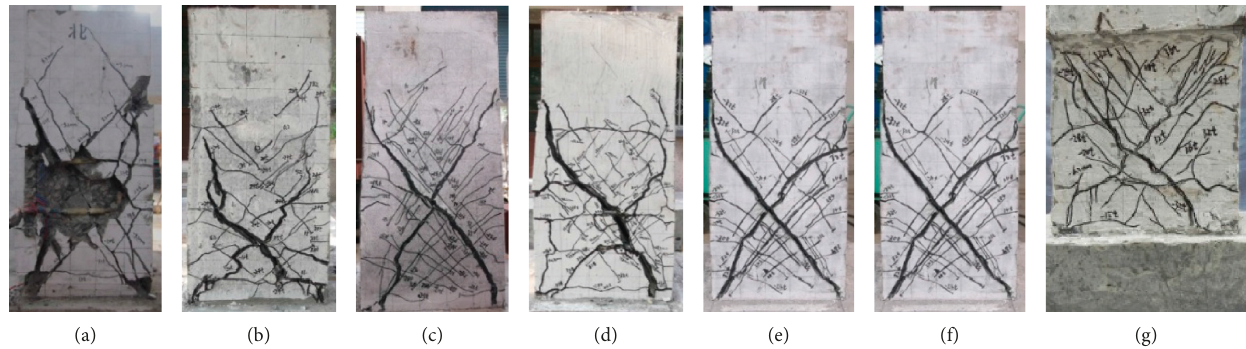
Figure 7: Final failure patterns: (a) RC1, (b) HDC2, (c) HDC3, (d) HDC4, (e) HDC5, (f) HDC6, and (g)